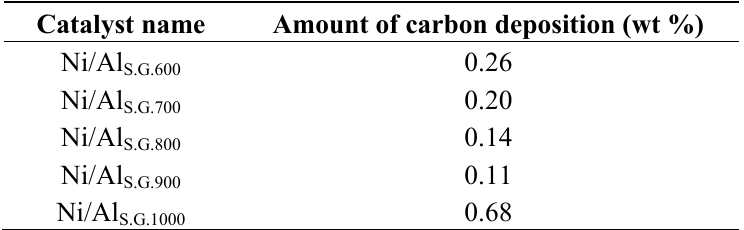
Table 3. Carbon deposited on the used catalysts after 8 h